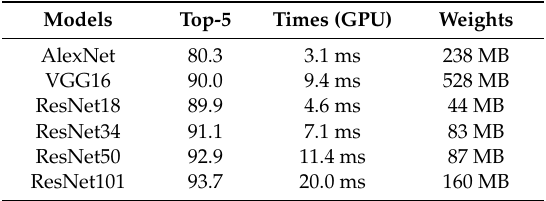
Table 1. Specifically, the performances of ResNet are superior to that of the AlexNet and the VGG, and they can increase their Top-5 performance by increasing the depth of the network structure. Despite the Top-5 percentage of ResNet50 is only 0.8% lower than that of ResNet101, its computation time and memory usage are almost half of those of the ResNet101. Table 1. Pre-trained models for ImageNet classification